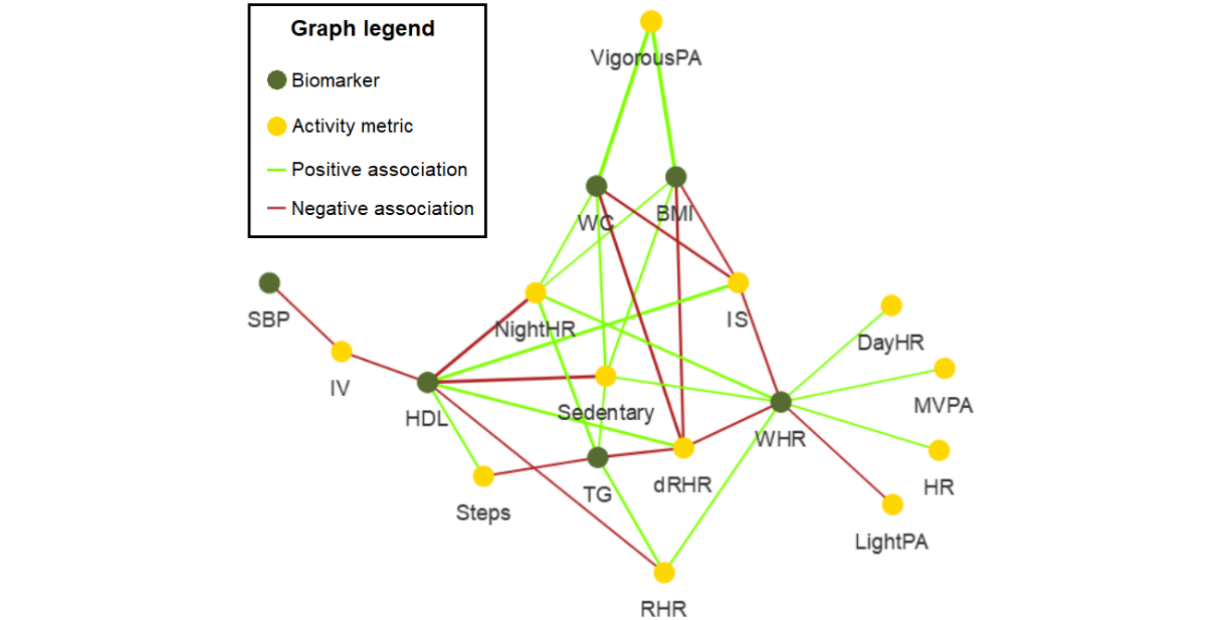
Figure 4. Correlation network of cardiometabolic disease biomarkers and activity tracker metrics. Only associations significant at P <.05 were displayed. Width of lines is proportional to absolute value of Spearman coefficients that vary between 0.22 and 0.38. BG: blood glucose; DayHR: daytime heart rate; DBP: diastolic blood pressure; dRHR: delta of resting heart rate; HDL: high-density lipoprotein; HR: heart rate; IS: interdaily stability of locomotor activity rhythm; IV: interdaily variation of locomotor activity; LDL: low-density lipoprotein; MVPA: moderate-to-vigorous physical activity; NightHR: nighttime heart rate; PA: physical Activity; RHR: resting heart rate; SBP: systolic blood pressure; TG: triglyceride; WC: waist circumference; WHR: waist-to-hip